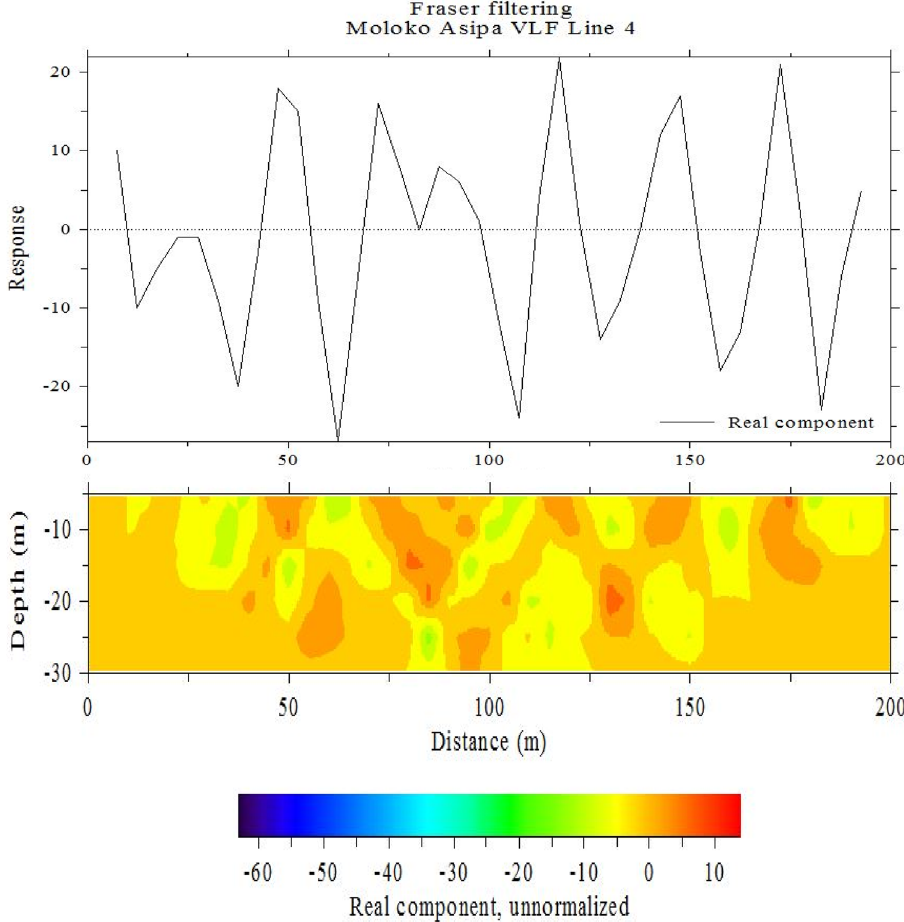
Fig. 5 Fraser and Karous–Hjelt representation for traverse